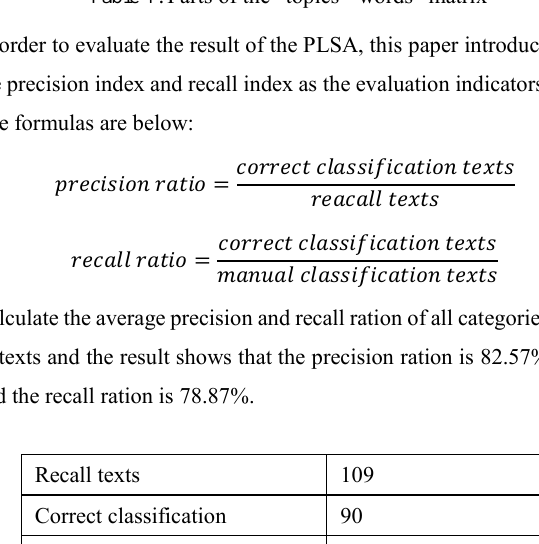
Table 1. Parts of the “topics - words” matrix